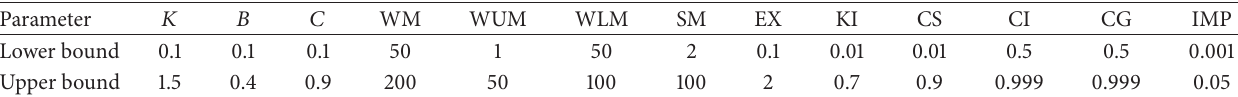
Figure 1: Flow chart for the XAJ model. Table 1: Lower and upper bounds on the